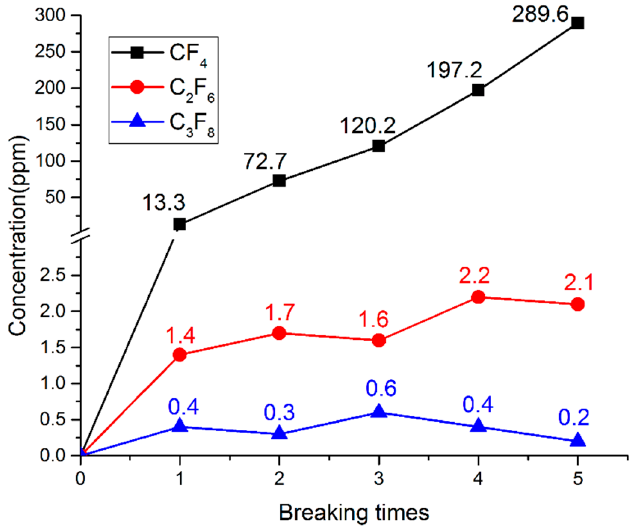
Figure 5. The change of CF 4 , C 2 F 6 , and C 3 F 8 concentrations with the breaking times.